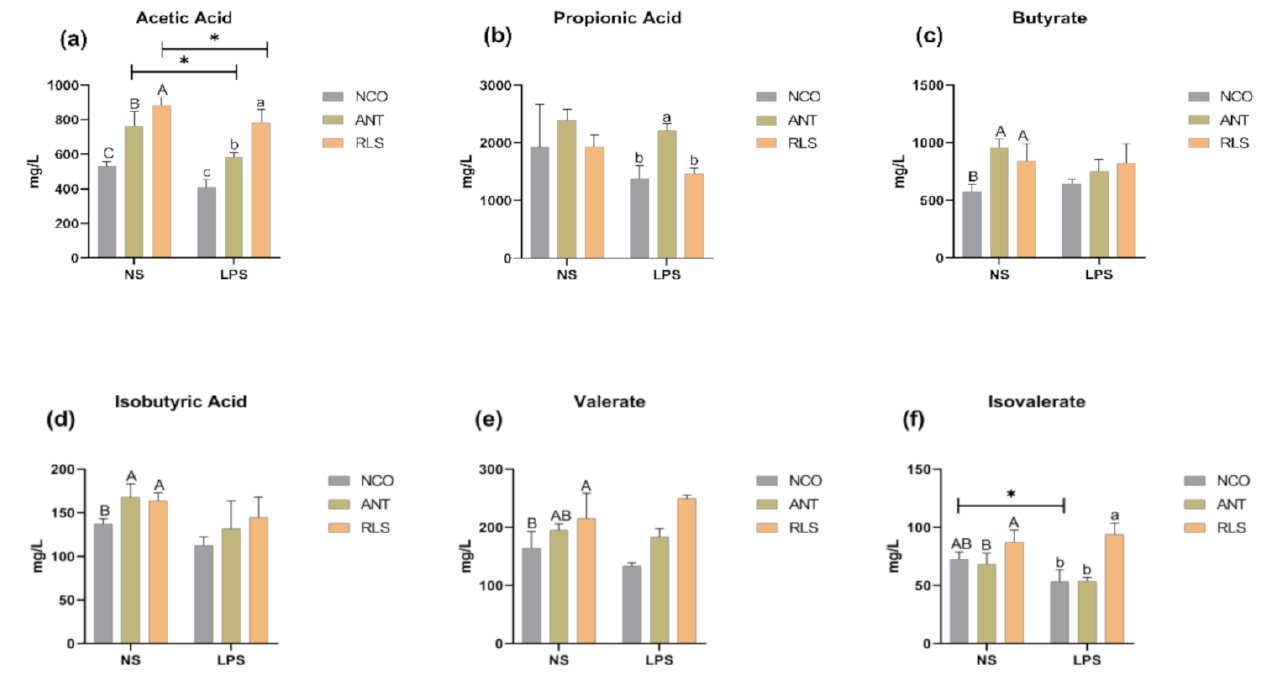
Figure 4. Effects of RLS on SCFAs in colon morphology in broilers challenged with LPS. ( a ) Effect of RLS on acetic acids. ( b ) Effect of RLS on prophionic acid. ( c ) Effect of RLS on butyrate. ( d ) Effect of RLS on isonutyric acid. ( e ) Effect of RLS on valerate. ( f ) Effect of RLS on isovalerate. NS-NCO represents control broilers treated with normal saline; NS-ANT represents broilers treated with the antibiotic; NS-RLS represents broilers treated with rhamnolipids; LPS-NCO represents control broilers challenged with LPS; LPS-ANT represents broilers treated with the antibiotic and challenged with LPS; LPS-RLS represents broilers treated with rhamnolipids and challenged with LPS; * and different superscript letters indicate significant differences ( p < 0.05), majuscule present NS-groups and lowercase present LPS-groups, n =